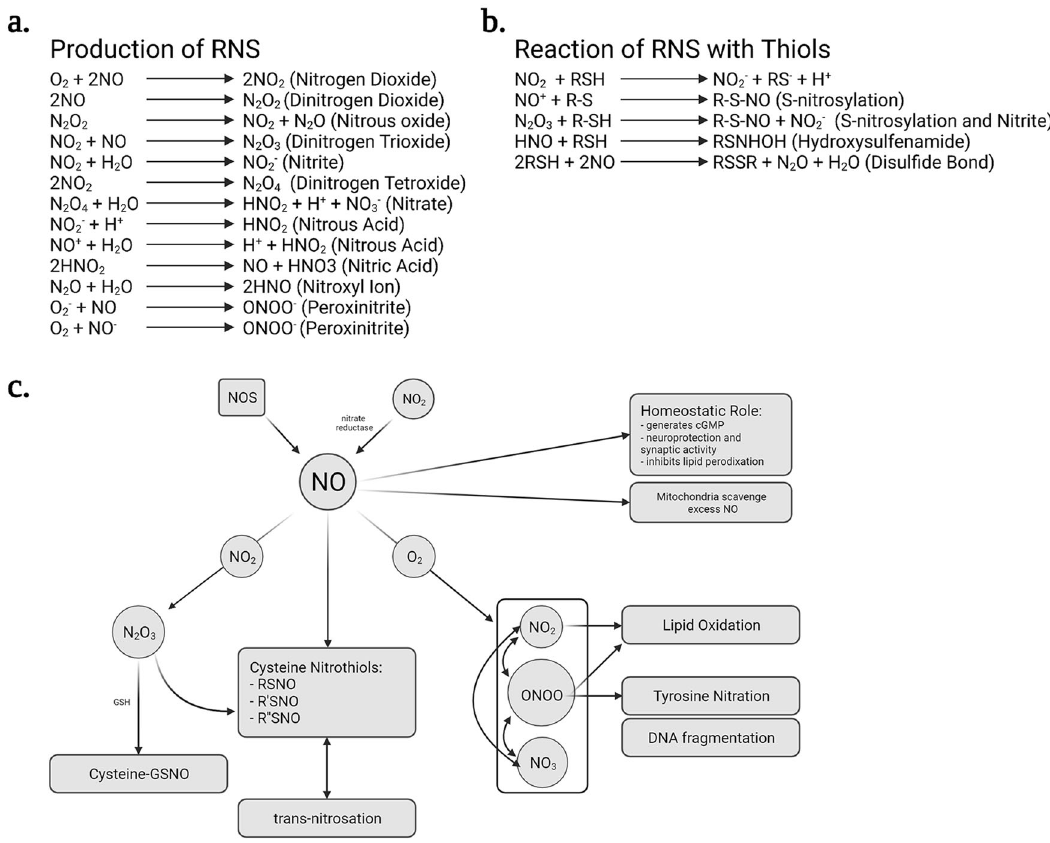
Fig. 1 Sources of reactive nitrogen species. Various formulas showing the production of reactive nitrogen species are displayed ( a ). The known reactions between RNS and thiols are also shown ( b ). A cartoon depicting the primary effects of various RNS and their intermediates ( c ). This fi gure was created using